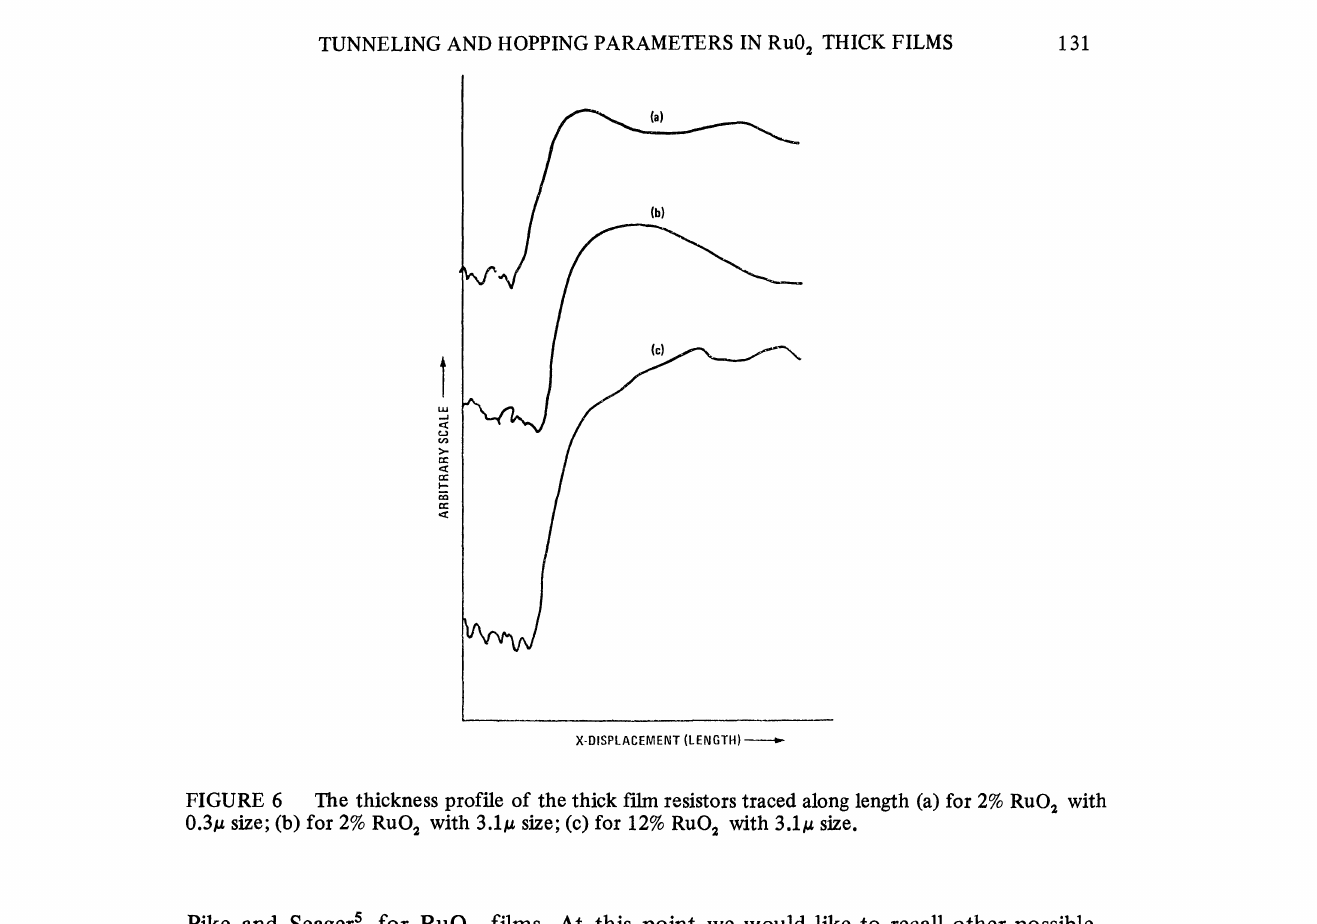
Pike and Seager for RuO films. At this point we would like to recall other possible mechanisms not considered earlier,